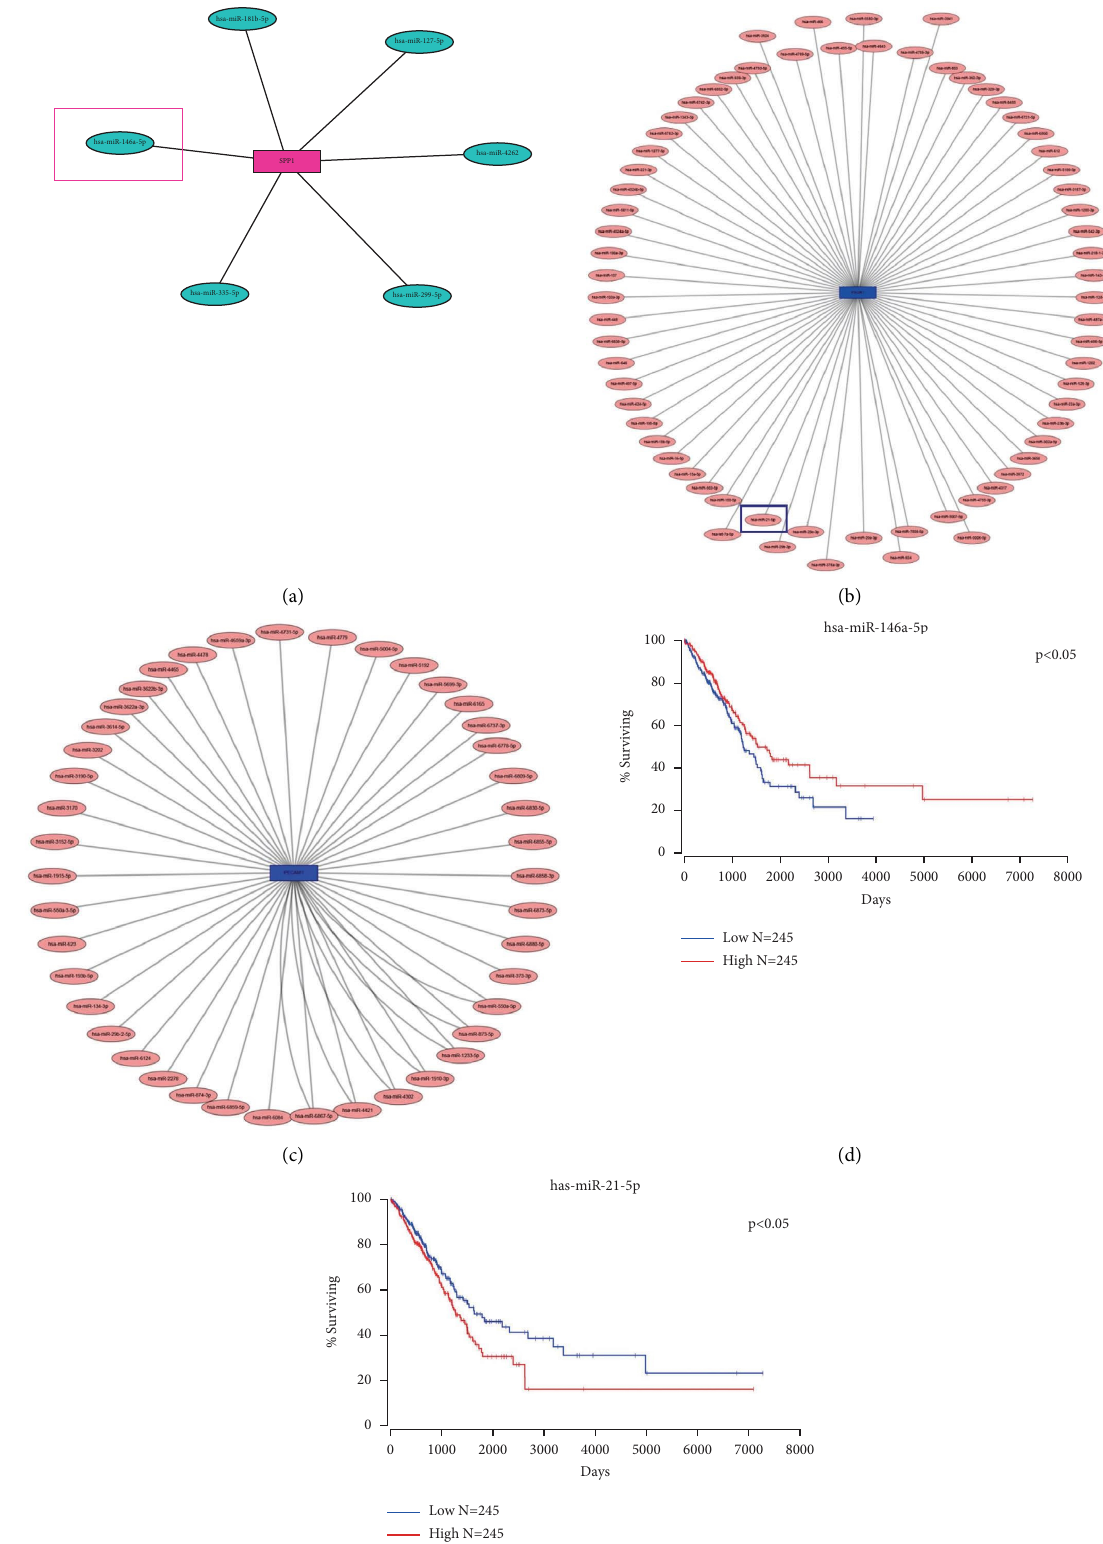
Figure 8: Upstream miRNA prediction and survival analysis of the three genes were conducted with the miRtarbase. (a) SPP1. (b) PIK3R1. (c) PECAM1. (d, e) miRNA survival analysis used the OncoLnc website, and hsa-miR-146a-5p and hsa-miR-21-5p were signifcantly correlated with overall survival